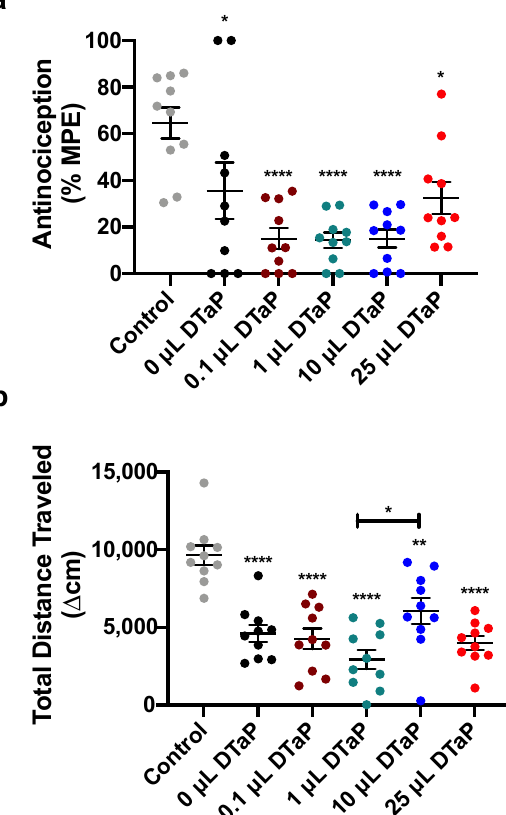
Figure 4. TT-6-AmHap vaccine efficacy in DTaP immunized animals as assessed on the hot plate and in the locomotion assays 10 weeks after primary immunization. Naive control mice (gray dots) and immunized mice were challenged with 1 mg/kg heroin SC and tested with the ( a ) hot plate nociceptive assay and ( b ) locomotion assay. Antinociception is expressed as percent maximum possible effect (%MPE) for the hot plate test. The difference between the pre- and post-heroin challenge values represents the total distance traveled (cm) in the locomotion assay. Values represent the mean ± S.E.M. Statistical differences between groups were determined by one-way ANOVA with Tukey’s multiple comparisons test. N = 10/group; * p <0.05; ** p < 0.01; **** p < 0.0001; compared to the naive control; ns: not significant.